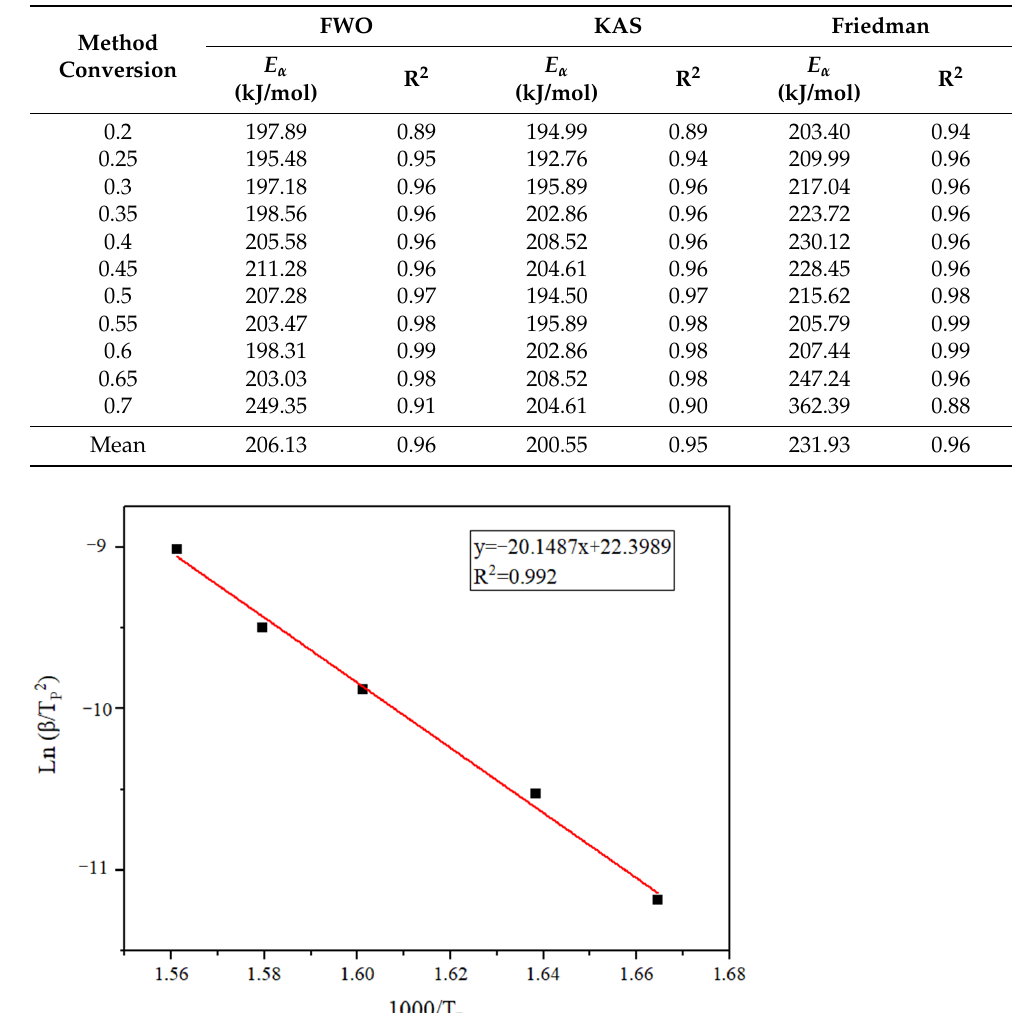
Table 4. The activation energy for chicken manure derived from FWO, KAS and Friedman methods.